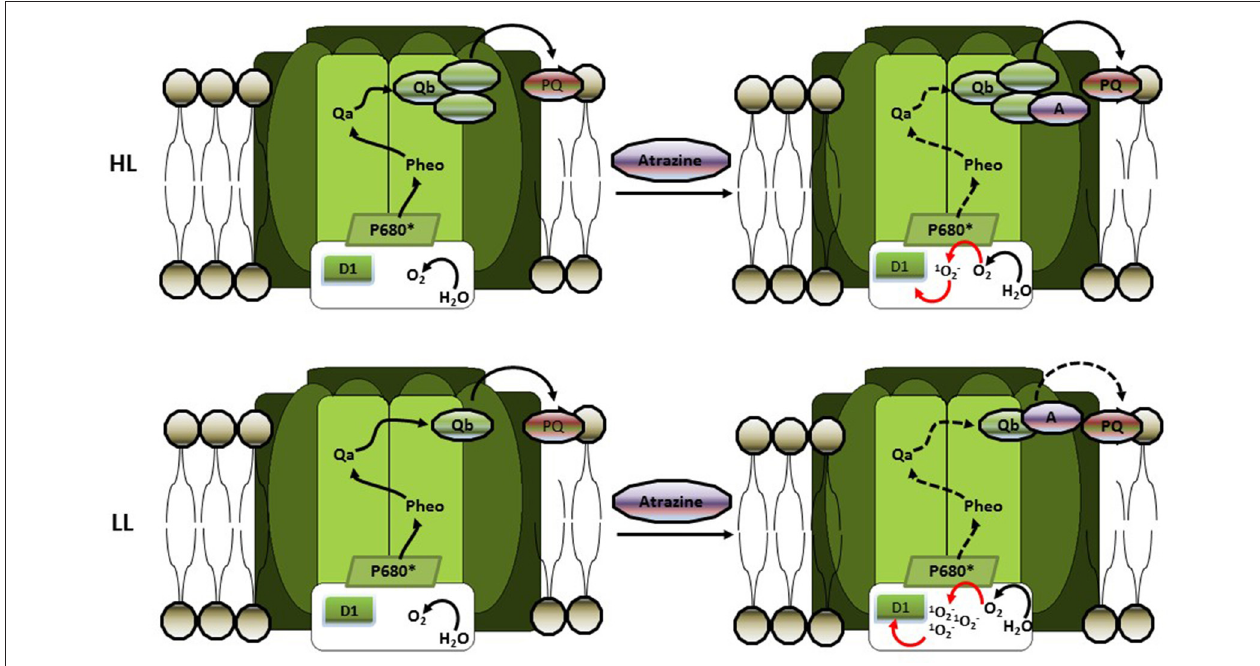
FIGURE 3 | The influence of high light (HL) and low light (LL) acclimation on atrazine toxicity in phytoplankton (according to Deblois et al., 2013). HL-adaptation increases the quinone pool, thus increasing the number of atrazine targets. This dilution effect decreases reactive oxygen production (ROS) due to atrazine-induced photoinhibition, thus decreasing the hazardous effects of that herbicide. In LL adapted cells, on the other hand, the lack of sufficient quinone to maintain electron transport will drastically increase (ROS) production and oxidative damage.